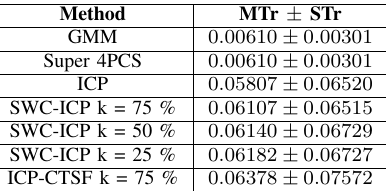
TABLE XII: Best seven methods for video ‘freiburg2 xyz’ according to translation average (equation (48)) with standard deviations given by expressions (50).